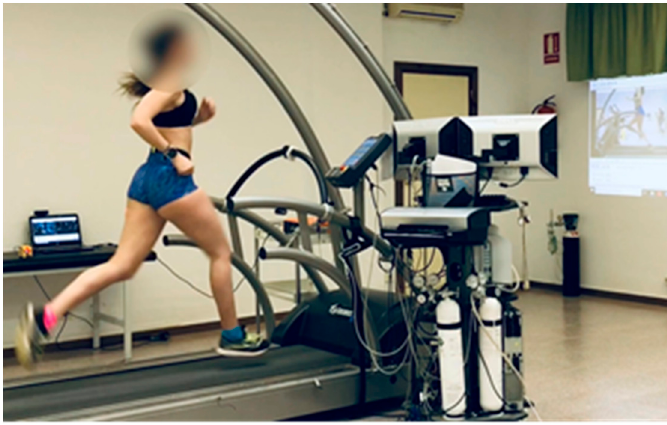
Figure 1. Visual real-time biofeedback during the retraining protocol.